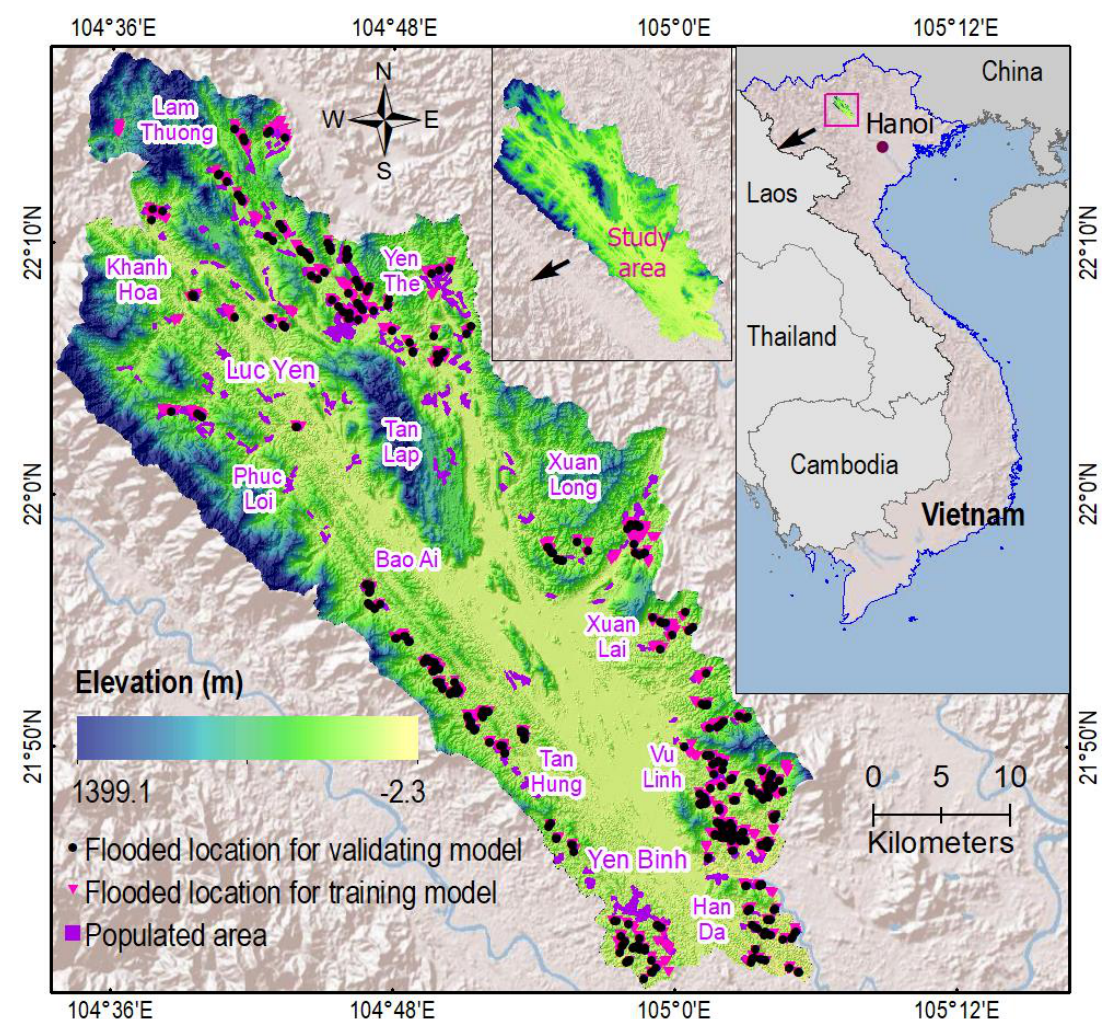
Figure 1. Location of the Luc Yen district and flash-flooded locations.